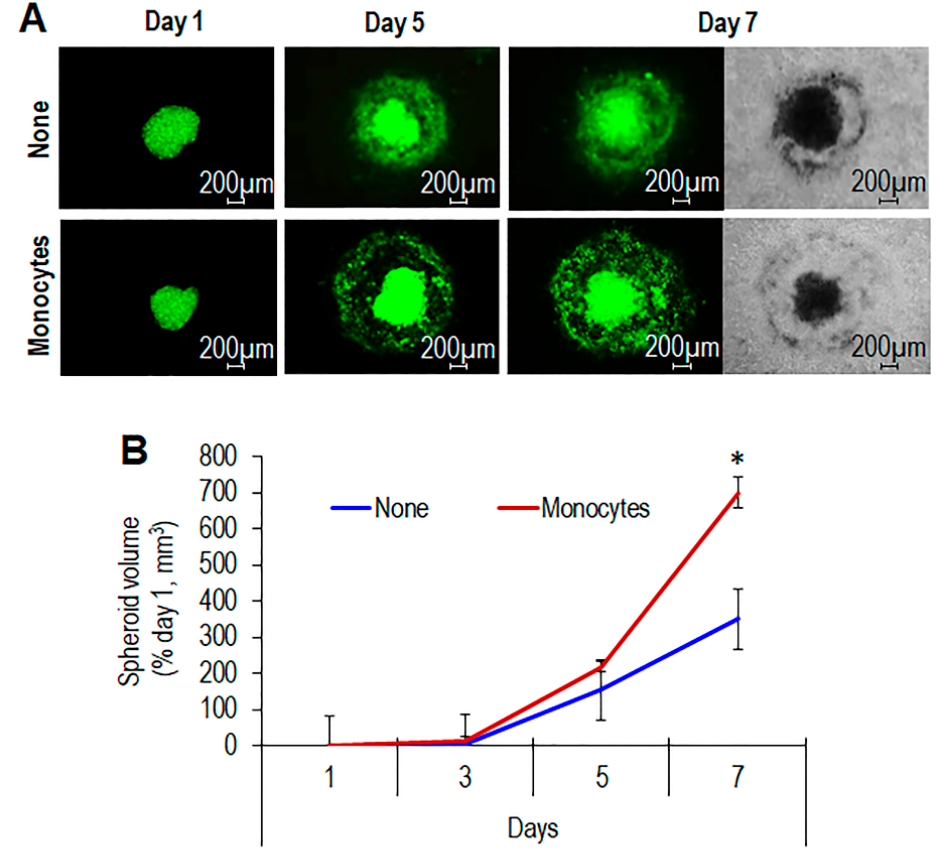
Figure 4. Time-dependent increase of spheroid size induced by primary monocytes. ( A ). Spheroids containing GFP-tagged CHS cells obtained from the tumor sample of #16 patient were embedded in the collagen / fibroblast mixture without (None), or with the addition of human monocytes. At the indicated times, fluorescent and transmitted-light input images were acquired at 50 × magnification. ( B ). Time-dependent increase of spheroid size. Data expressed as percentage of volumes assessed at time zero are the mean ± SD of two independent experiments, performed in duplicate. Statistical significance with * p < 0.0001.